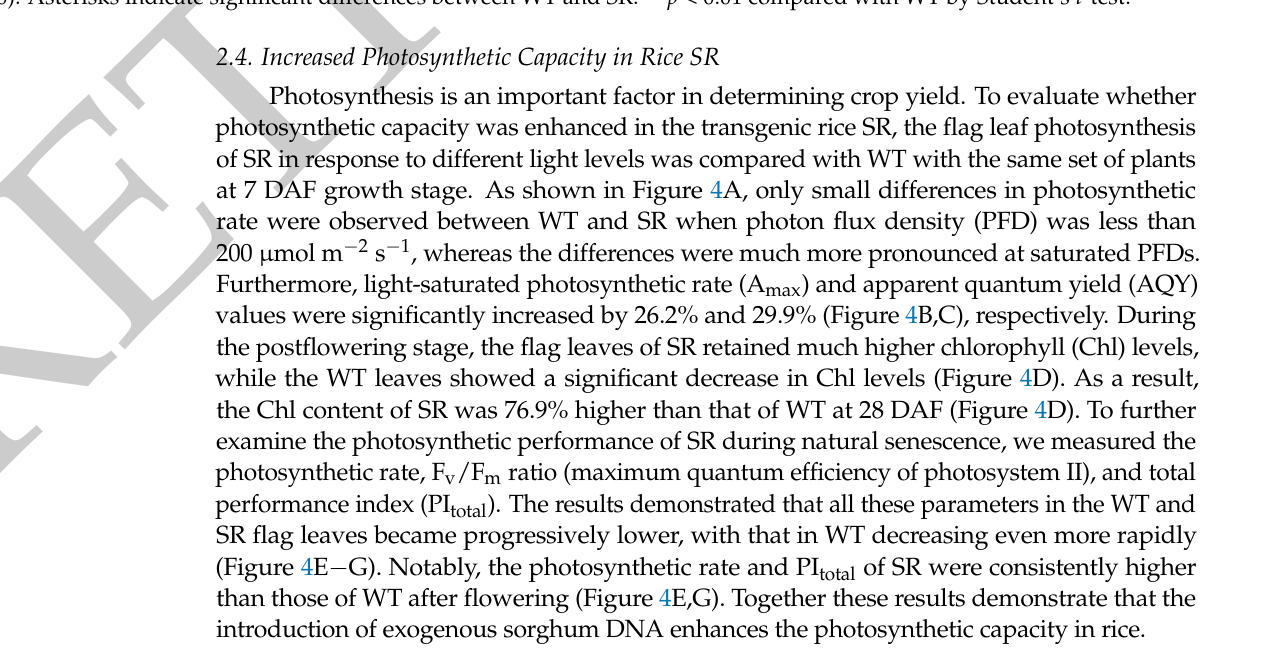
Figure 3. Comparing wild-type (WT) and transgenic plant sorghum-rice (SR) flag leaf phenotypes at 7 days after flowering (DAF). ( A ) Segregant leaf surface of WT (top) and SR (bottom). Bar, 5 mm. ( B ) Large bundle sheath number of WT and SR. ( C ) Small bundle sheath number of WT and SR. ( D ) Total bundle sheath number of WT and SR. ( E ) Interbundle sheath distance of WT and SR. ( F ) Flag leaf cross sections of WT (left) and SR (right) plants at 28 DAF. LBS, large bundle sheath; SBS, small bundle sheath; BSC, bundle sheath cell; MC, mesophyll cell. Bar, 100 µ m. ( G , H ) Transmission electron micrographs of leaf sections showing bundle sheath cells and mesophyll cells from WT (top) and SR (bottom) at 14 DAF. Ch, chloroplast; ST, stromal thylakoid; GT, grana thylakoid; SG, starch grain; P, plastoglobule. Bars, 1 μ m. Values ( B – E ) are given as means ± SD ( n = 10). Asterisks indicate significant differences between WT and SR. ** p < 0.01 compared with WT by Student’s t -test.